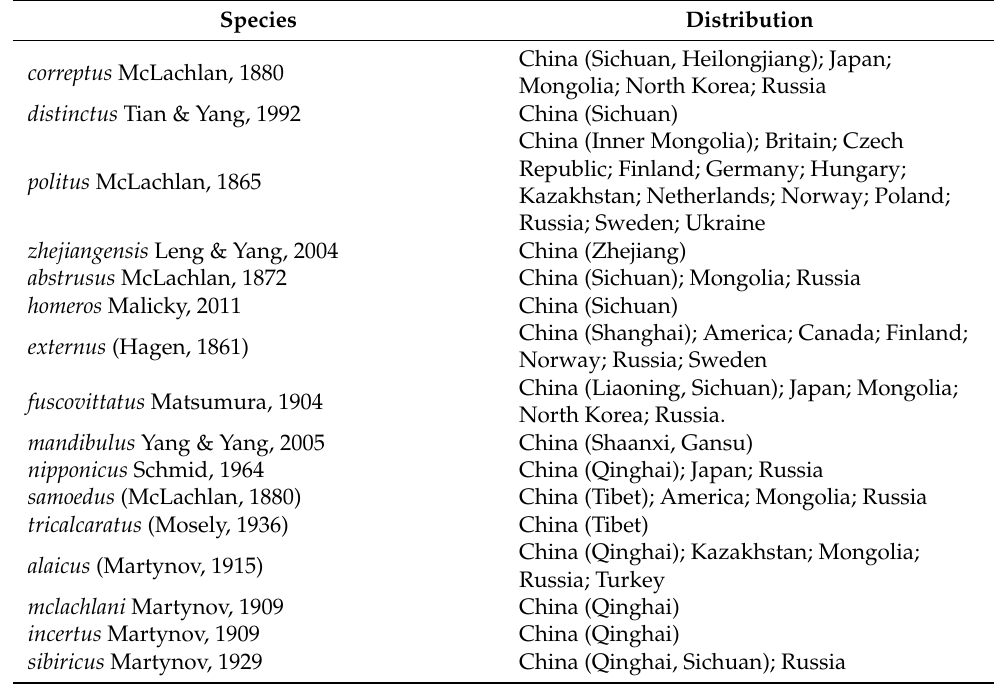
Table 1. Species of Limnephilus recorded from the Chinese